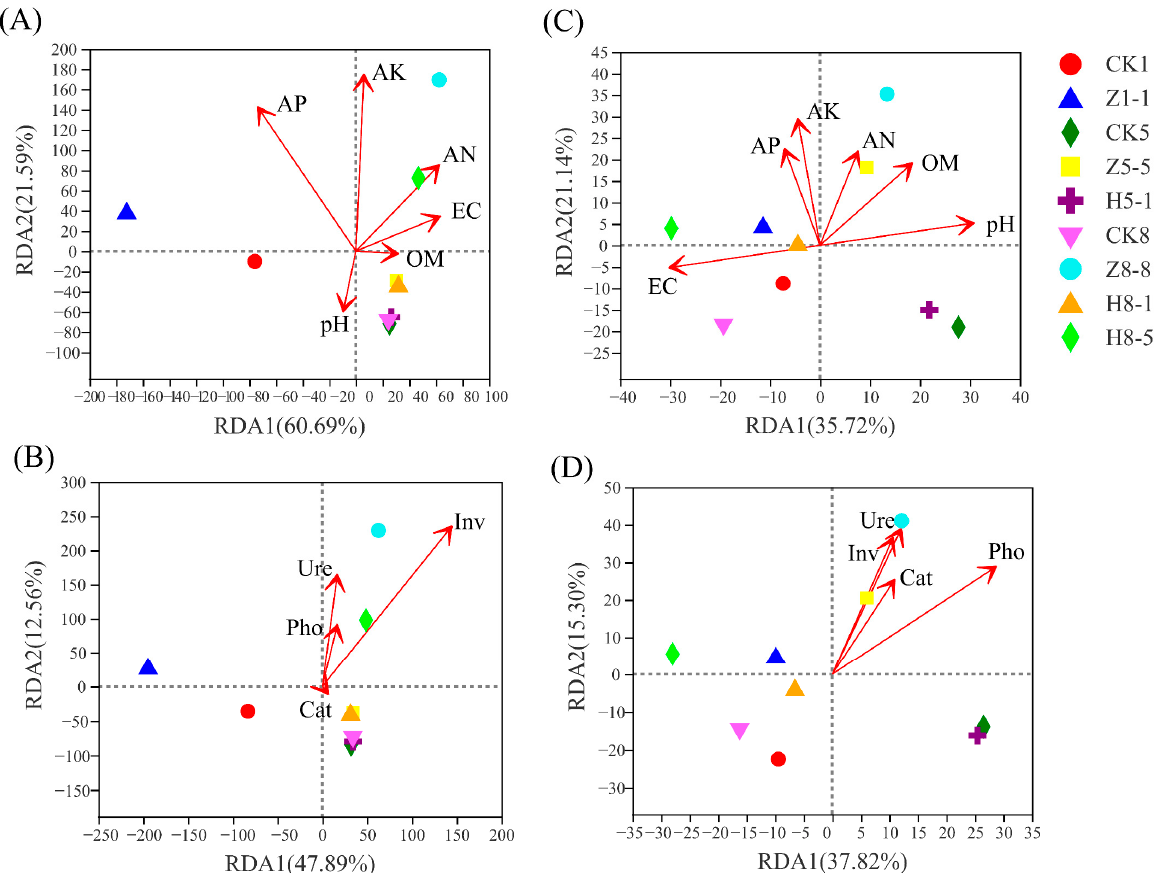
Figure 10. Redundancy analysis (RDA) of microbial community changes with soil parameters. Note: